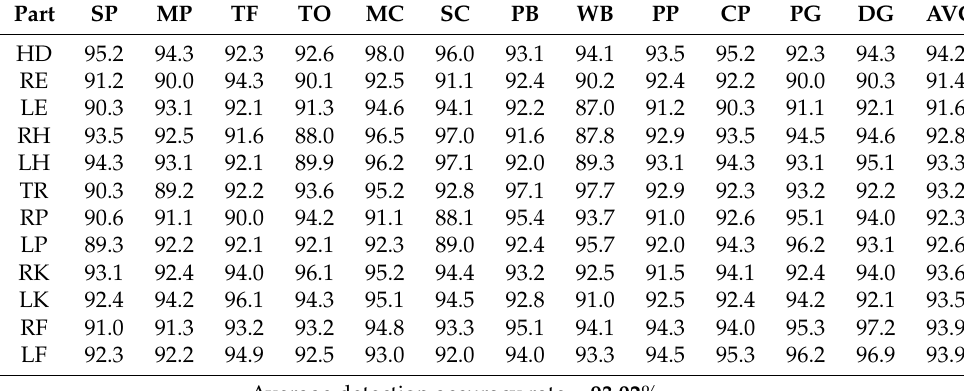
Table 6. Results of body part detection over the SYSU 3D HOI